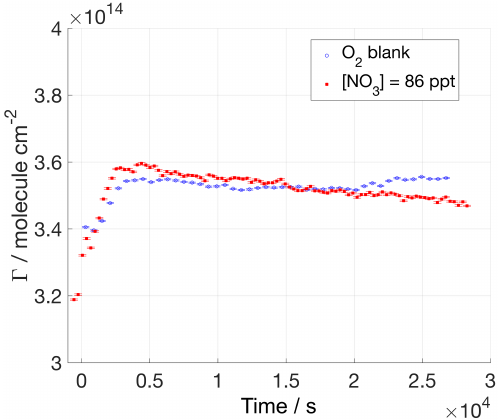
Figure 10. Surface excess of stearic acid ( d 35 SA) exposed to O 2 (blue circles) and to [NO 3 ] = 86ppt (red filled squares). Exposure to NO 3 starts at t = 0s. Both surface excess traces show an increase over the first 40min. There is slight subsequent decrease in the sur- face excess during exposure to NO 3